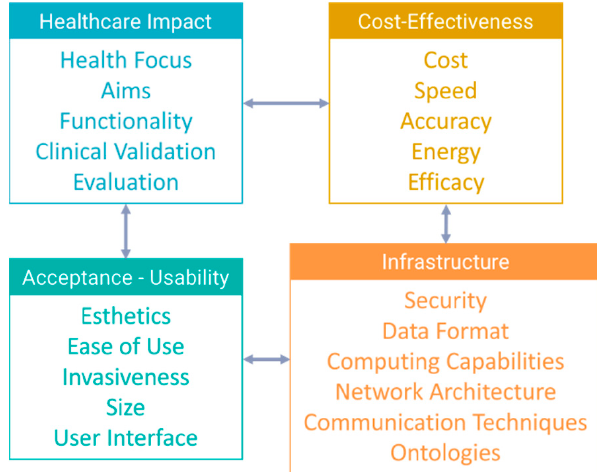
Figure 5. Categories of criteria examined in review studies.